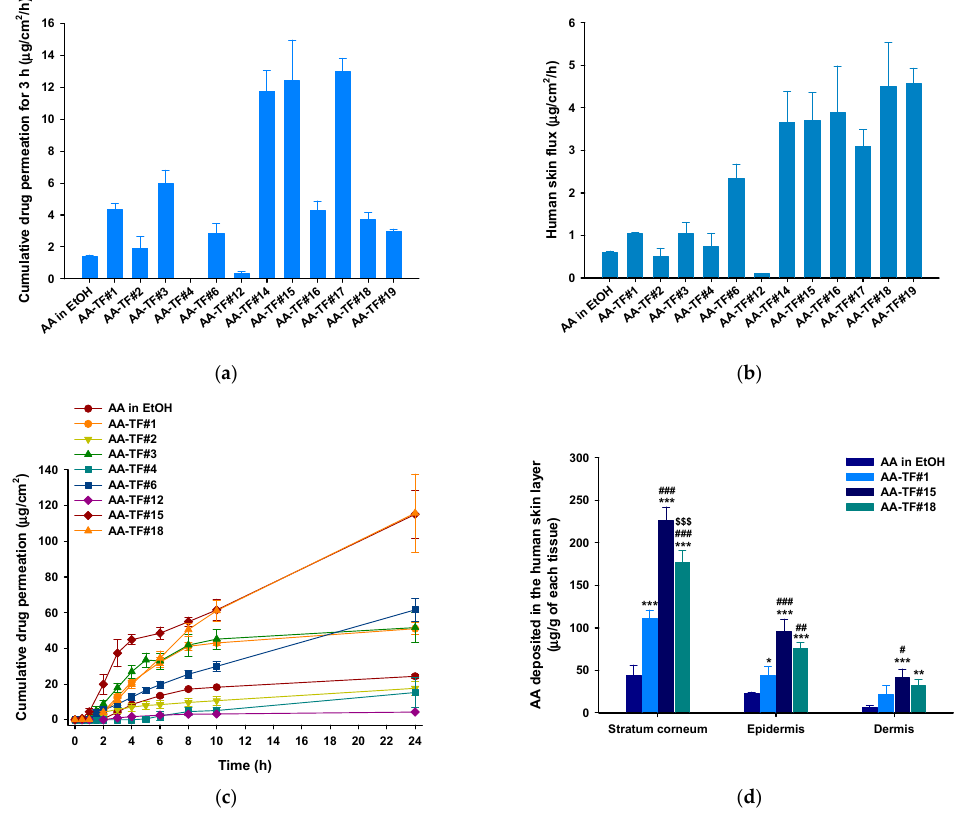
Figure 2. In vitro full-thickness human skin permeability of atraric acid (AA) in ethanol (EtOH) and topical formulations (AA–TFs): ( a ) Cumulative drug infiltration in human skin during the initial 3 h after treatment; ( b ) Skin flux with 1% AA in EtOH or AA–TFs over 24 h; ( c ) Time-course curve of cumulative AA permeation infiltration of 1% AA in EtOH or AA–TFs for 24 h; ( d ) AA deposited in the human stratum corneum, epidermis, and dermis using 1% AA in EtOH, AA–TF#1, AA–TF#15, and AA–TF#18 24 h after loading. * p < 0.05, ** p < 0.01, and *** p < 0.001 compared to AA in EtOH; # p < 0.05, ## p < 0.01, ### p < 0.001 compared to AA–TF#1; $$$ p < 0.001 compared to AA–TF#15. Values are presented as means ± SDs ( n = 4 for each group).